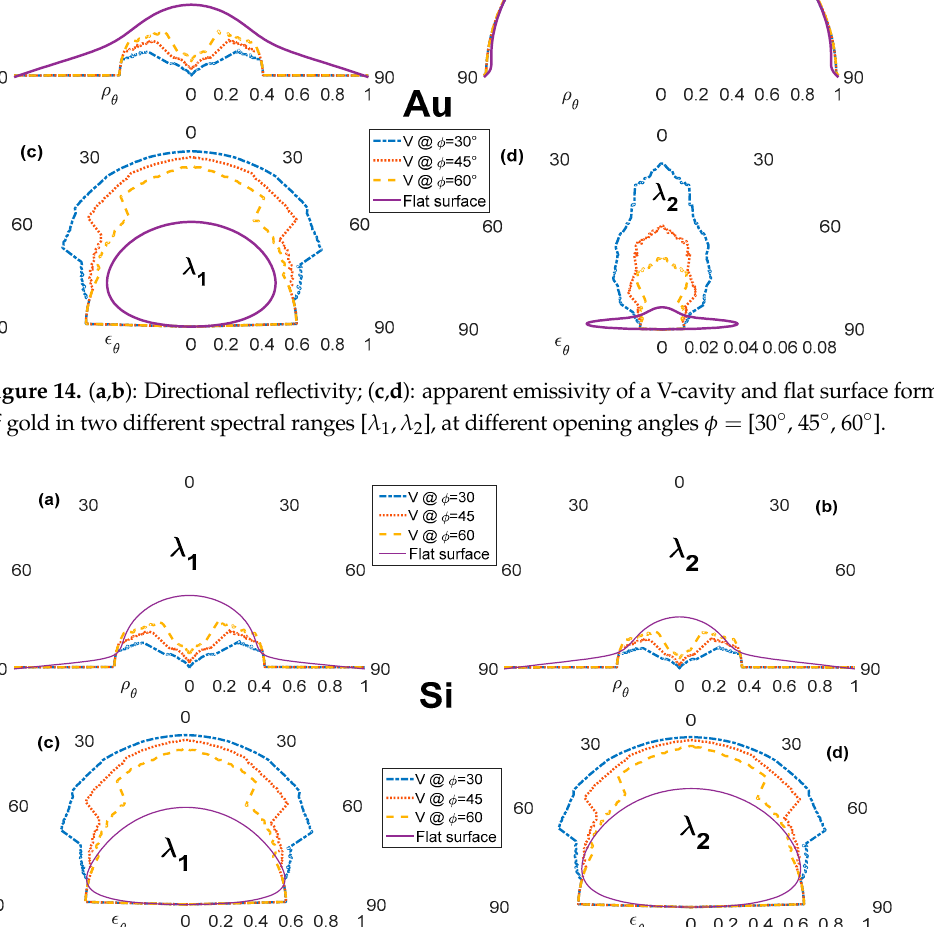
Figure 15. ( a , b ): Directional reflectivity; ( c , d ) apparent emissivity of a V-cavity and flat surface formed of silicon in two different spectral ranges [ λ 1 , λ 2 ], at different opening angles φ = [30 ◦ , 45 ◦ , 60 ◦].